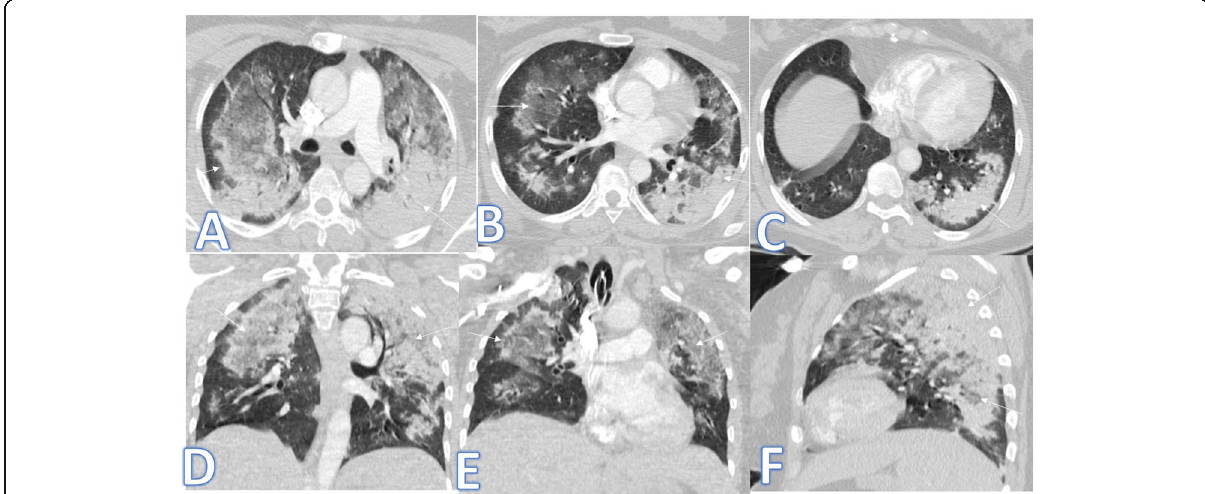
Fig. 7 A 46-year-old female patient with SLE, presented with hemoptysis. CT showed bilateral confluent consolidative patches with GGO (arrows) more predominant in the upper lobes with subpleural and costophrenic angle sparing. The diagnosis was diffuse alveolar